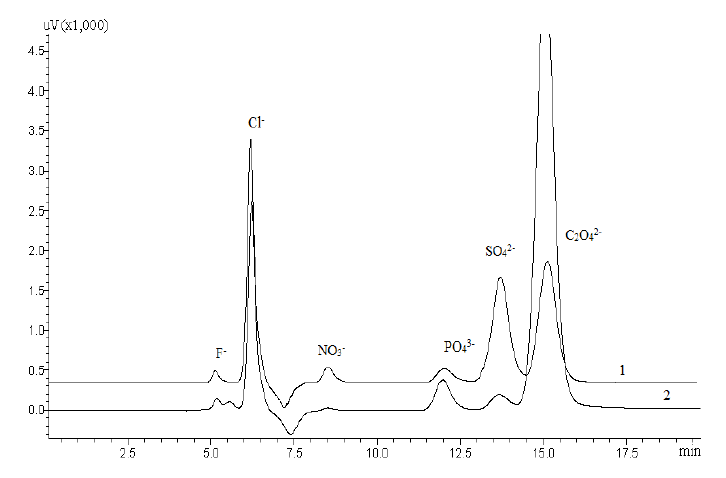
Figure 1. Chromatograms of: (1) model anions mixture F - , 0.1 mg L -1 ; Cl - , 4.0 mg L -1 ; NO 3- , 3.0 mg L -1 ; PO 43- , 1.5 mg L -1 ; SO 42- , 5.0 mg L -1 ; C 5.0 mg L -1 ; (2) urinary stone